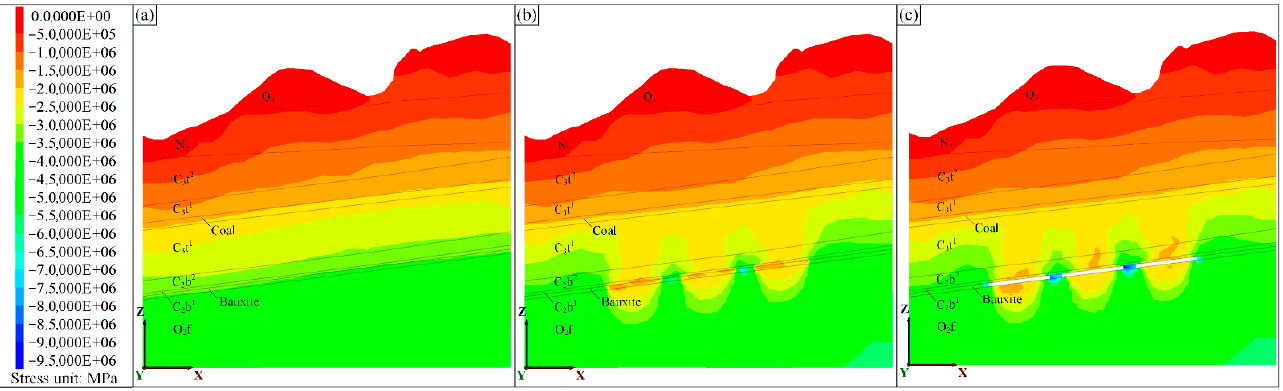
Figure 7. Distribution of minimum principal stress: ( a ) non-mining condition; ( b ) normal backfilling condition; ( c ) non- backfilling condition.